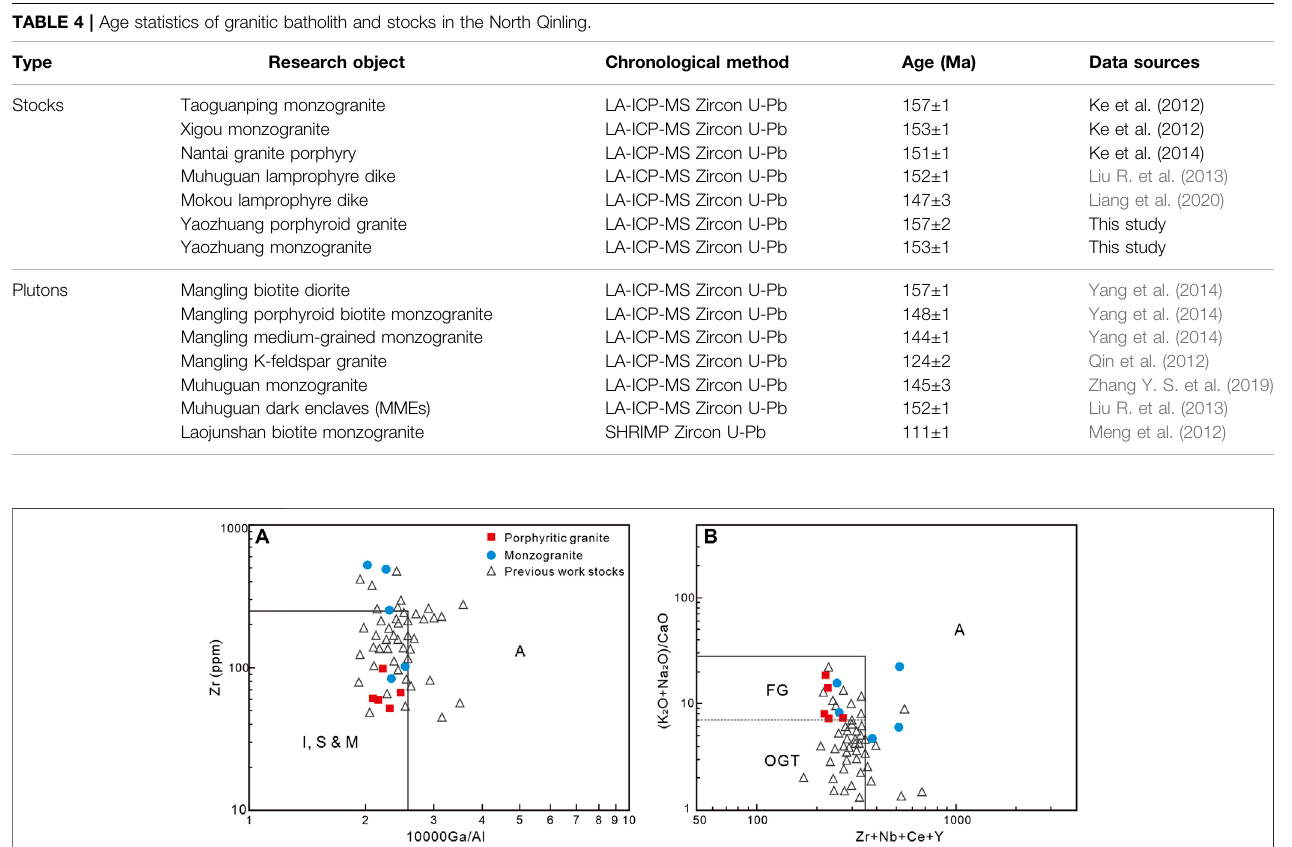
Frontiers in Earth Science |